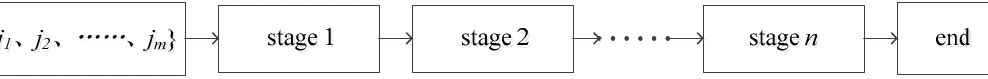
Figure 3. The layout of permutation flow shop scheduling.